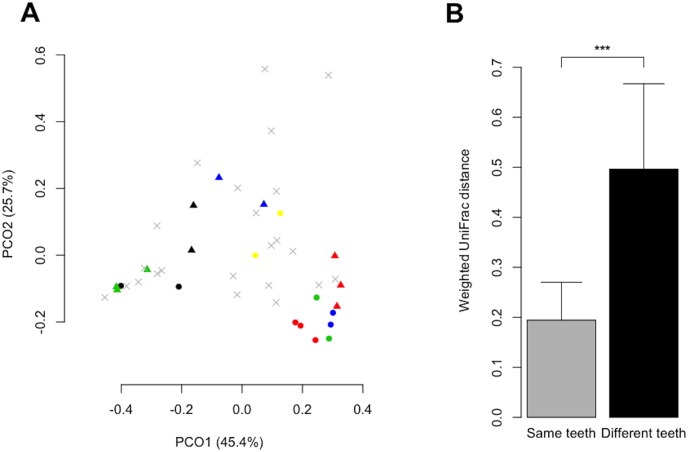
UniFrac analysis of the microbiota in carious dentin lesions.A. Principal coordinate analysis (PCoA) diagram based on weighted UniFrac distance showing the similarity relationships among the 44 carious dentin samples collected from 32 subjects. These two components explained 71.1% of the variance. Multiple samples collected from the same caries region are plotted in the same shape and color. Single samples are plotted as a gray cross (×). B. Weighted UniFrac distances between samples collected from the same caries region (the same teeth) and those between samples collected from the deepest layer of dental caries regions of different subjects (different teeth). ***P<0.001, Student’s t-test.